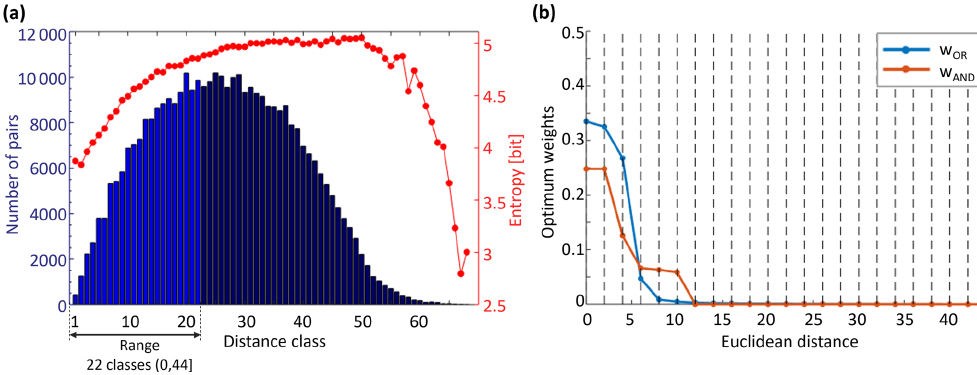
Figure 6. LR1-600, with (a) class cardinality and (b) optimum weights – Eqs. (4) and (5).